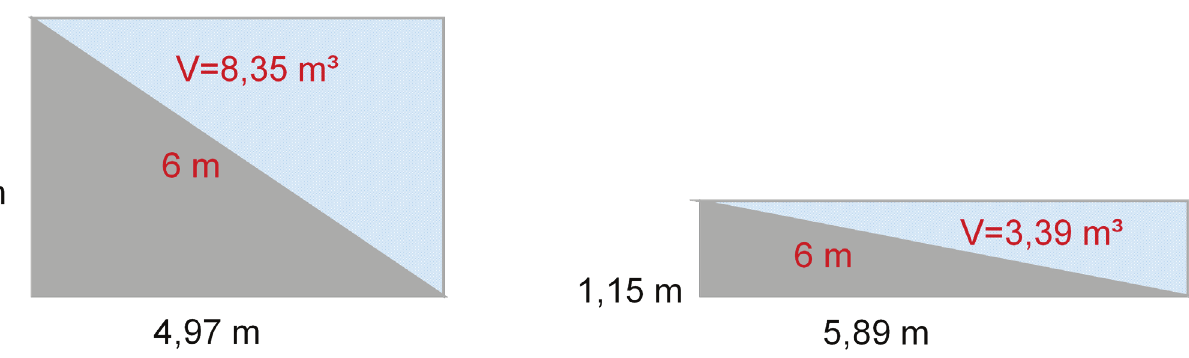
Figure 8. Schematic presentation of different volume capacities by the same area with a width of 1